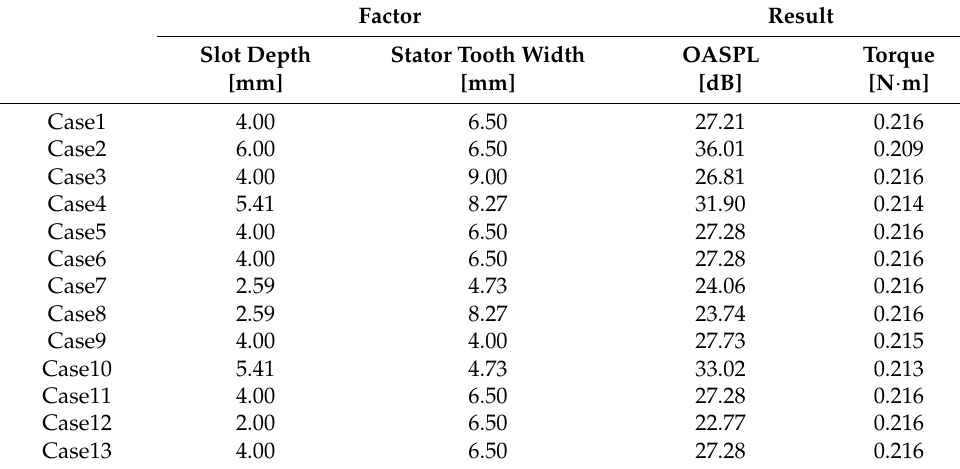
Table 6. Factors of central composite design and results.